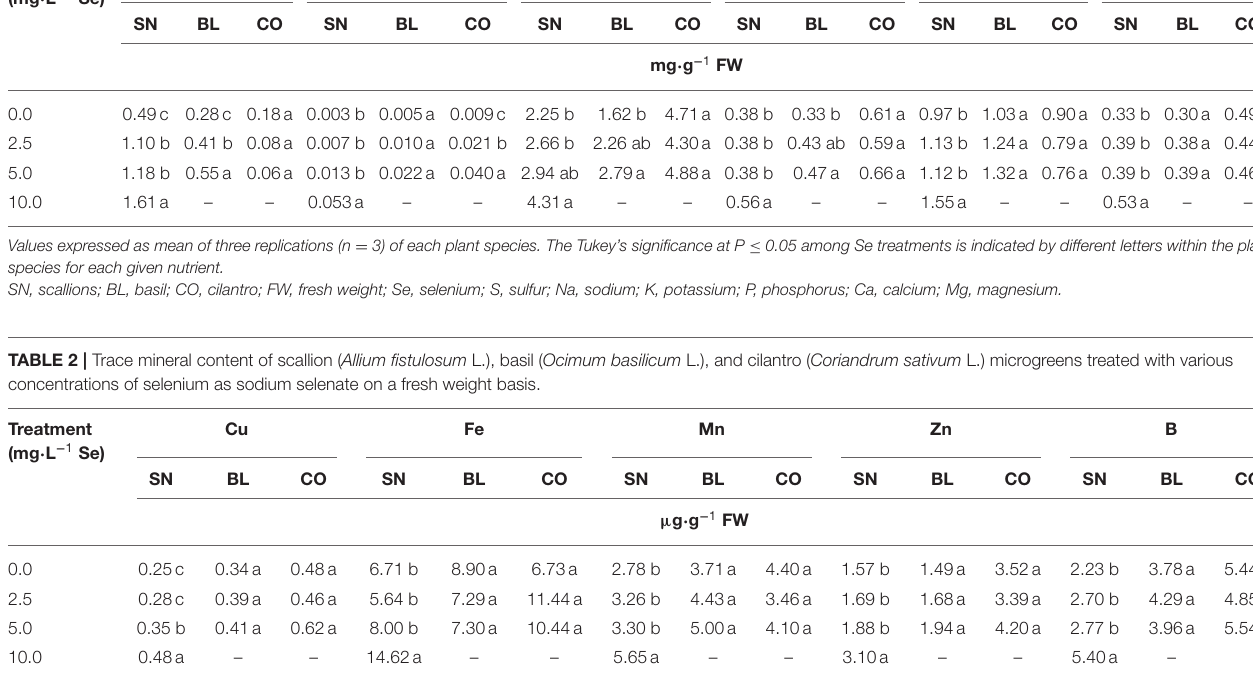
TABLE 1 | Major mineral content of scallion ( Allium fistulosum L.), basil ( Ocimum basilicum L.), and cilantro ( Coriandrum sativum L.) microgreens treated with various concentrations of selenium as sodium selenate on a fresh weight basis. Treatment (mg · L − 1 Se)